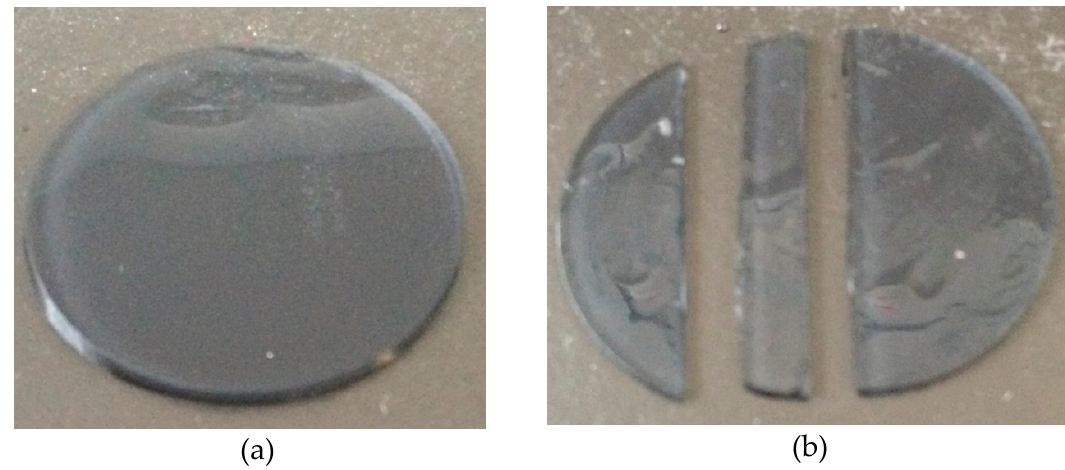
Figure 1. Image of an H77p0-clear hydrogel sample (77% water-content (w-c) hydrogel) before ( a ) and after ( b ) being cut into a strip.